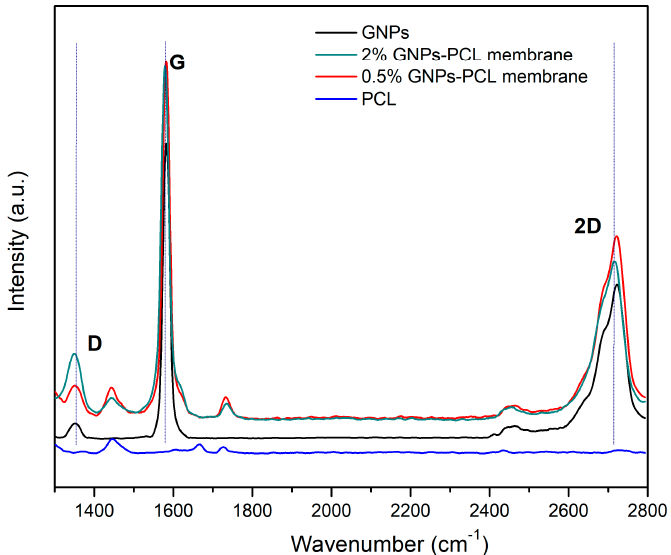
Figure 8. Raman spectra of the GNPs (black) PCL membrane (dark blue), 0.5% (red), and 2%GNPs-PCL membrane (light blue).